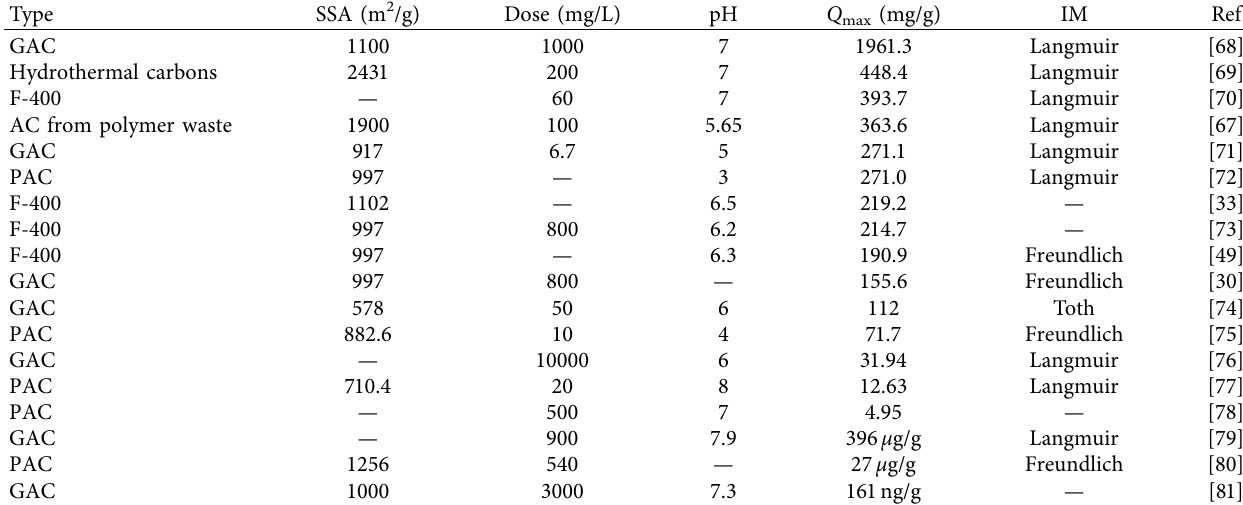
Table 4: Summary of characteristics of activated carbons and conditions of the adsorption process.